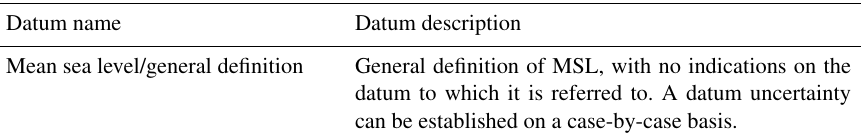
Table 2. Sea-level datums reviewed in this study (Rovere et al.,